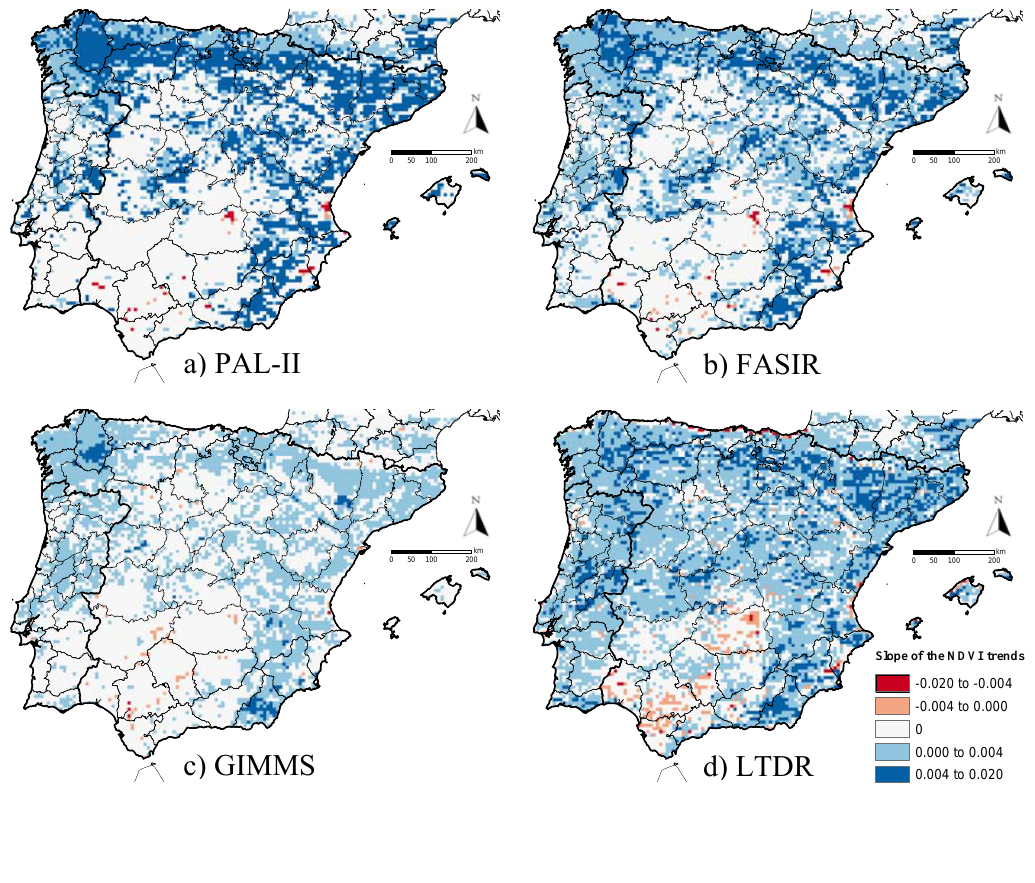
Figure 1. Difference in magnitude and spatial patterns of the significant 1982-1999 NDVI trends across four AVHRR datasets: (a) PAL-II, (b) FASIR, (c) GIMMS, and (d) LTDR for the Iberian Peninsula. Significant trends were considered for p-values < 0.05 by